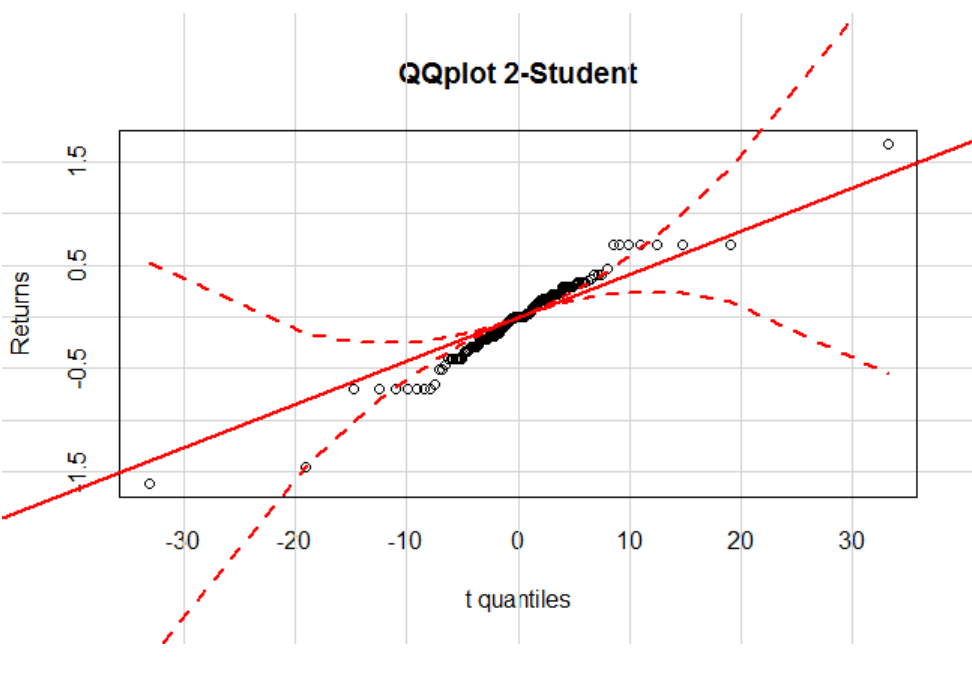
Figure 3. Q-Q normal